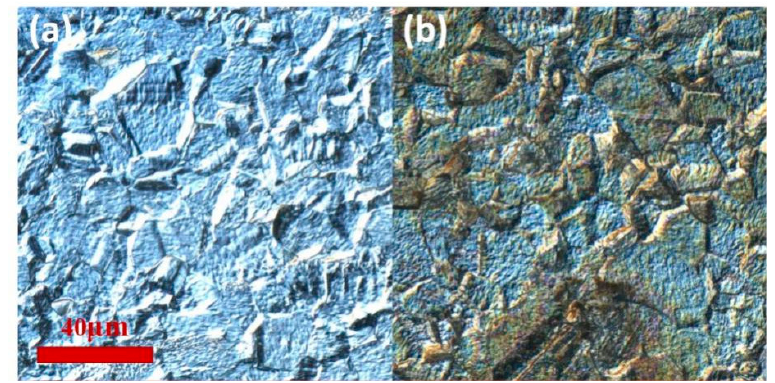
Figure 9. The metallographic lattice structure before and after the laser scanning treatment of 0.49 W and 1000 mm/s are shown in the confocal laser-scanning microscope images, ( a ): before, ( b ): after.